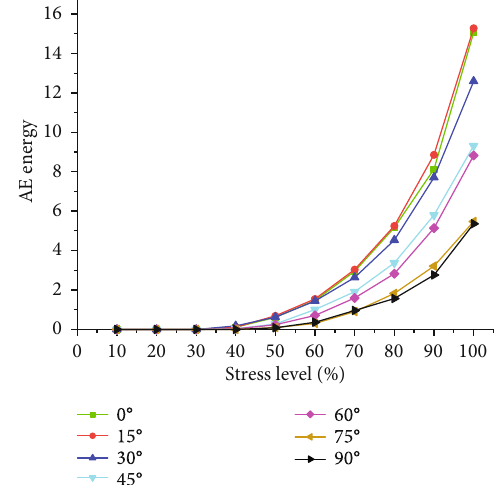
Figure 16: Relationship between stress levels and AE energy at di ff erent azimuth